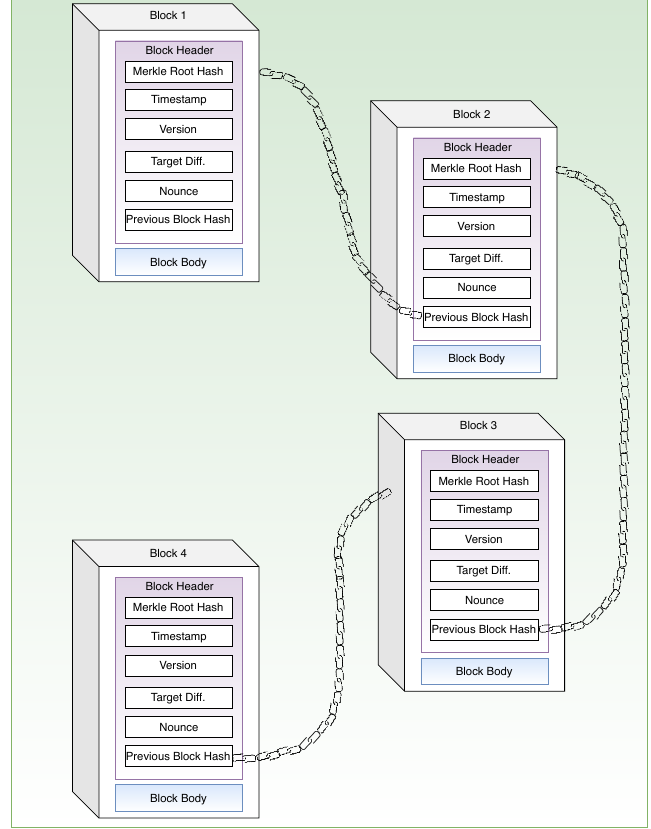
Figure 1. Blockchain